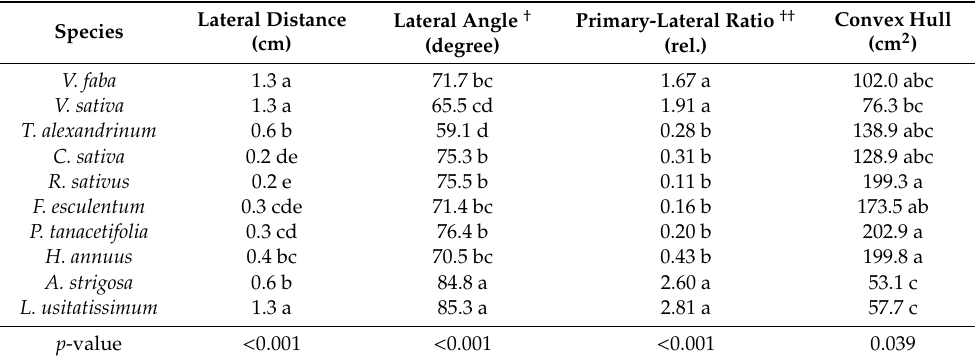
Table 2. Architectural characteristics of branching pattern obtained from a single (30 cm) primary root axis (manually